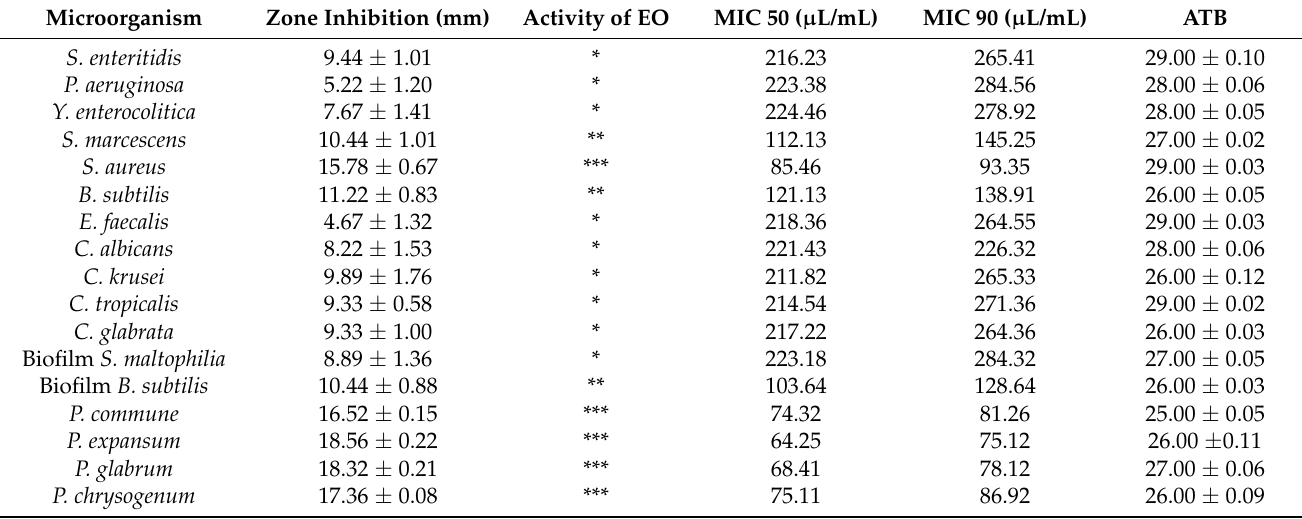
Table 2. Antimicrobial activity of S. aromaticum essential